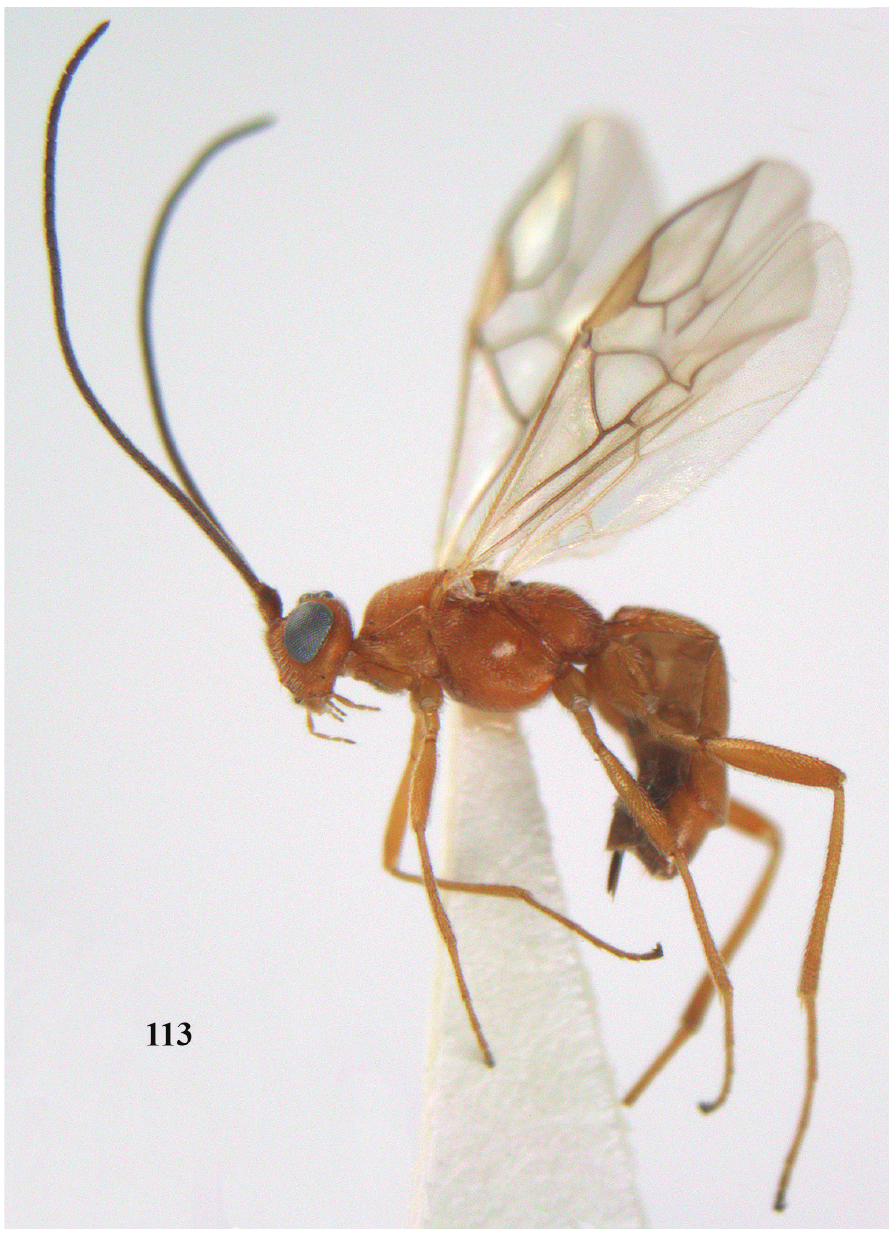
Figure 113. Aleiodes carminatus sp. n., ♀ , holotype, habitus lateral. 5104, 8.viii.[19]92, NMSZ1997.026, swept from Suaeda vermiculata ”; 2 ♀ + 1 ♂ (NMS, RMNH), id., but 28.vi.1992 and swept from Suaeda vera , ♂ swept from Osyris alba ; 3 ♀ (NMS, RMNH), id., but 12.ix.1991 (1) or 10.ix.1993 (2) and collected